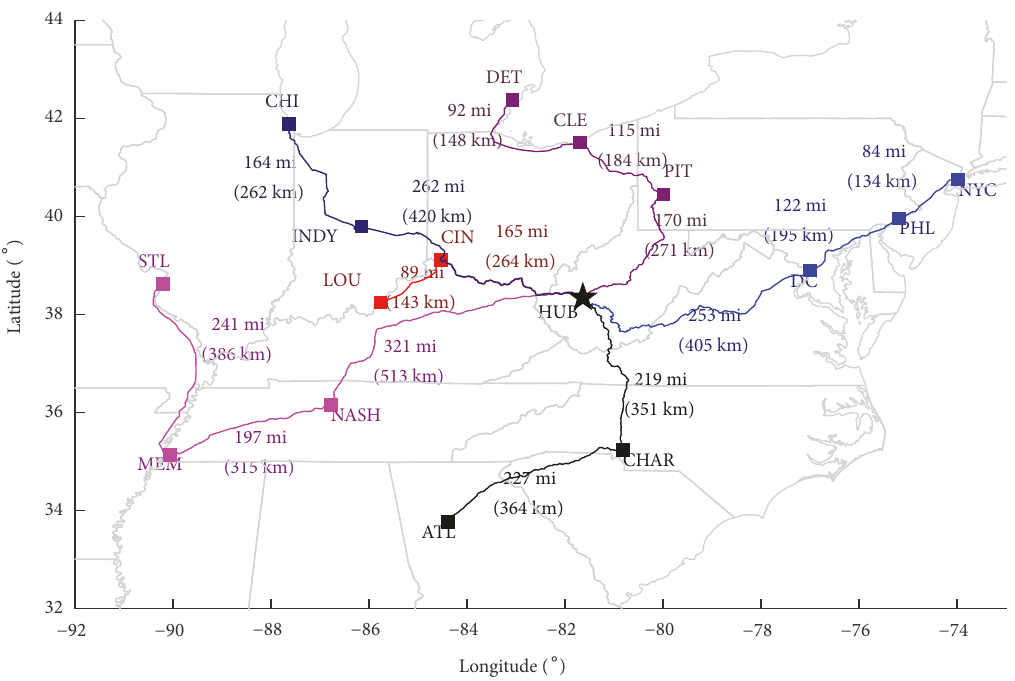
Figure 4: Solution 2: total distance = 2721.7563, iteration = 923; this solution was not selected due to the long distance of the train traveling the pink line shown.